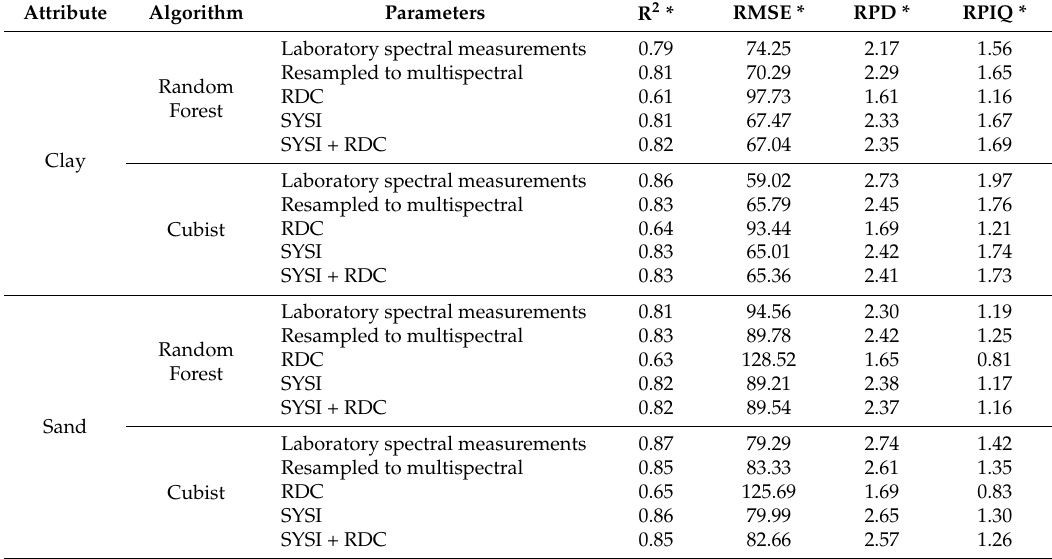
Table 3. Prediction validation statistics of clay and sand attributes applying Cubist and Random Forest models using a hyperspectral sensor in the laboratory, multispectral resampling in the laboratory, relief-derived covariates (RDC), Synthetic Soil Image (SYSI), and SYSI plus